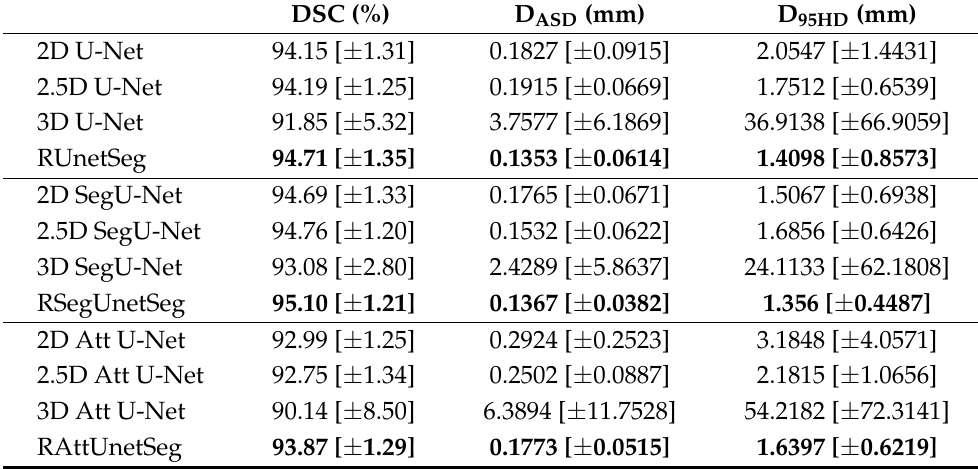
Figure 4. Examples of the automatic segmentation of mandibles in the UMCG dataset. ( a ) Ground truth segmentation on the three examples. ( b – m ) Segmentation results obtained on the example slices from 2D U-Net, 2.5D U-Net, 3D U-Net, RUnetSeg, 2D SegU-Net, 2.5D SegU-Net, 3D SegU-Net, RSegUnetSeg, 2D Att U-Net, 2.5D Att U-Net, 3D Att U-Net, and RAttUnetSeg. Cyan indicates the correctly segmented mandible compared to the ground truth. Pink represents the regions that were missed by the algorithms, while yellow indicates the segmented non-mandible regions. Table 2. Quantitative comparison of the segmentation performance between the proposed RCNNSeg- based approaches and the EDCNN-based methods on the PDDCA dataset. The values in the square brackets indicate the standard deviation of the corresponding measurements. We mark in bold the best performance in each